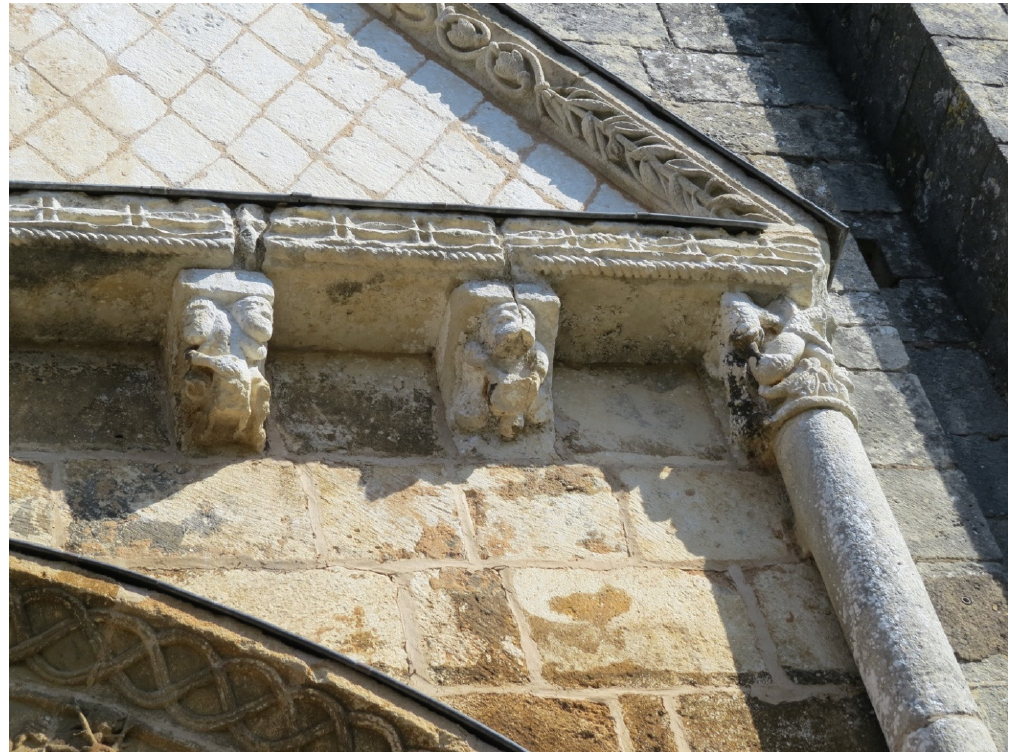
Figure 18. Corbels, detail, west façade, Saint-Martin Church , 12th c., Besse, Dordogne, Nouvelle- Aquitaine, France. ©Author. Aquitaine, France.